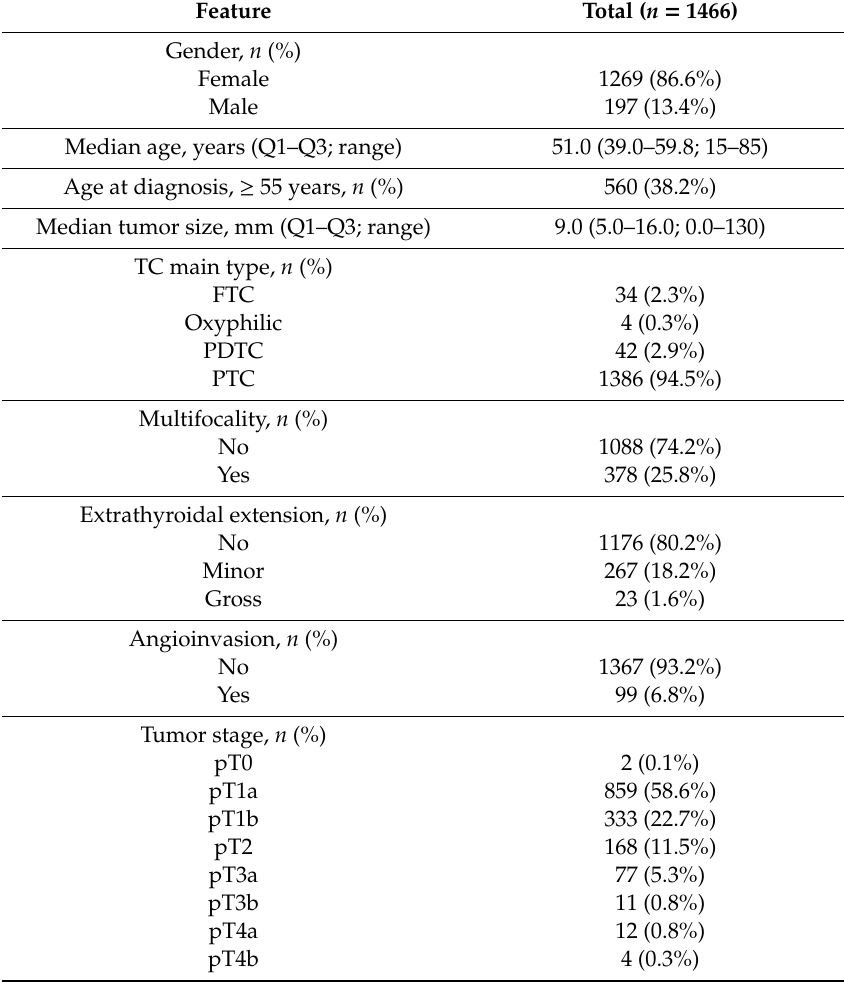
Table 1. Characteristics of the study